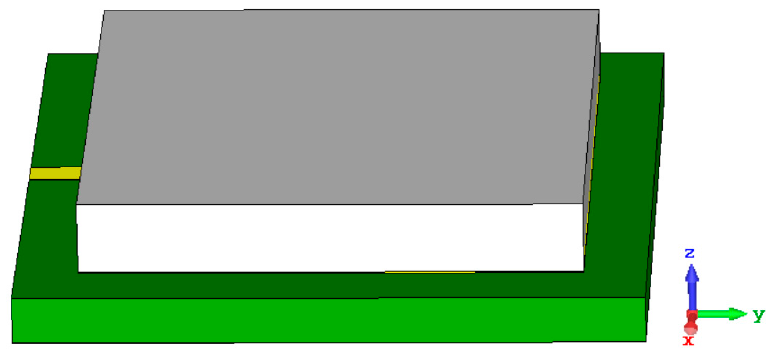
Figure 13. 3D view of a proposed sensor with the MUT.